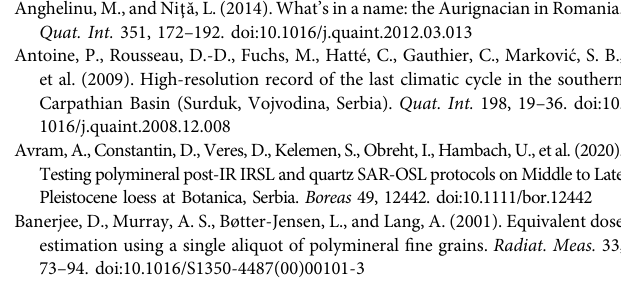
Supplementary Figure S1 , Thomas Albert on Figure 1C and Anja Rüschmann and So fi ja Dragosavac for drawing Figure 3